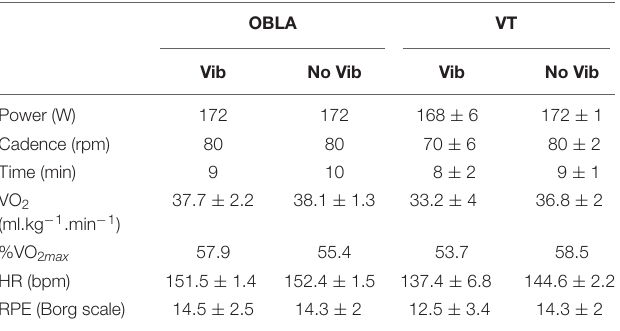
TABLE 5 | OBLA and VT variables during the vibration and no vibration